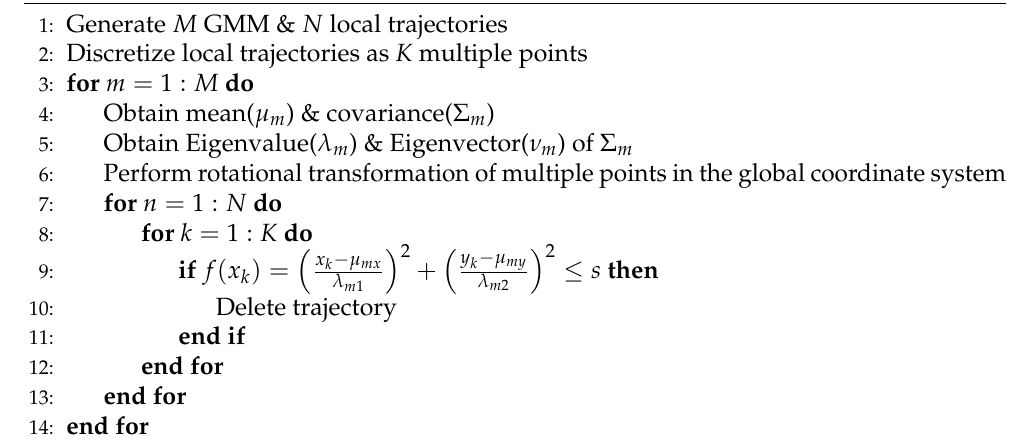
Algorithm 1 Examining whether a collision occurs, based on the GMM model and mo- tion primitives